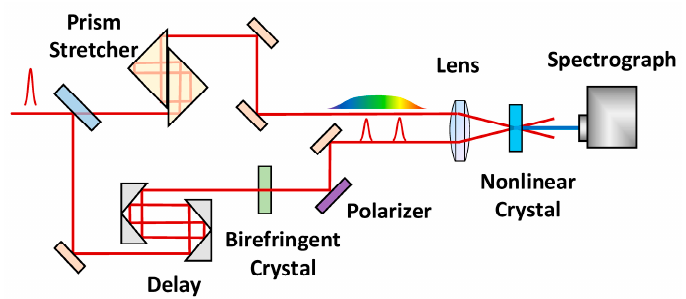
Figure 6. Schematic of a compact SPIDER with a birefringent pulse replicator and a compact stretcher Fig. 6 consisting of two oppositely placed rectangular prisms